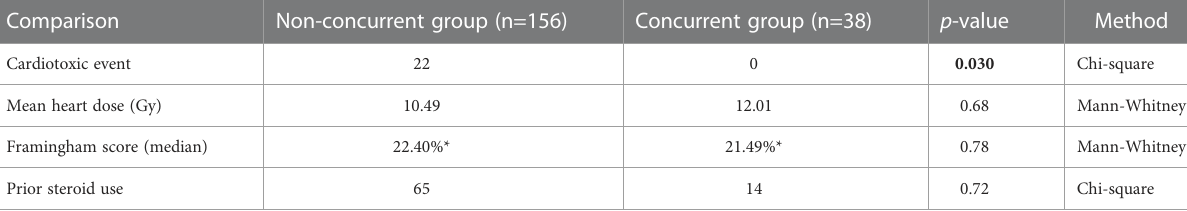
TABLE 6 Univariate analysis between patients who received ICI concurrently versus non-concurrently with thoracic RT.